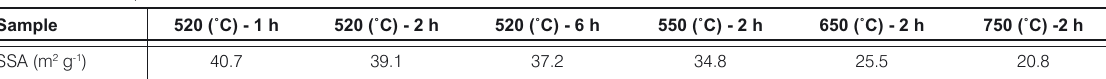
Table 2. BET specific surface areas.